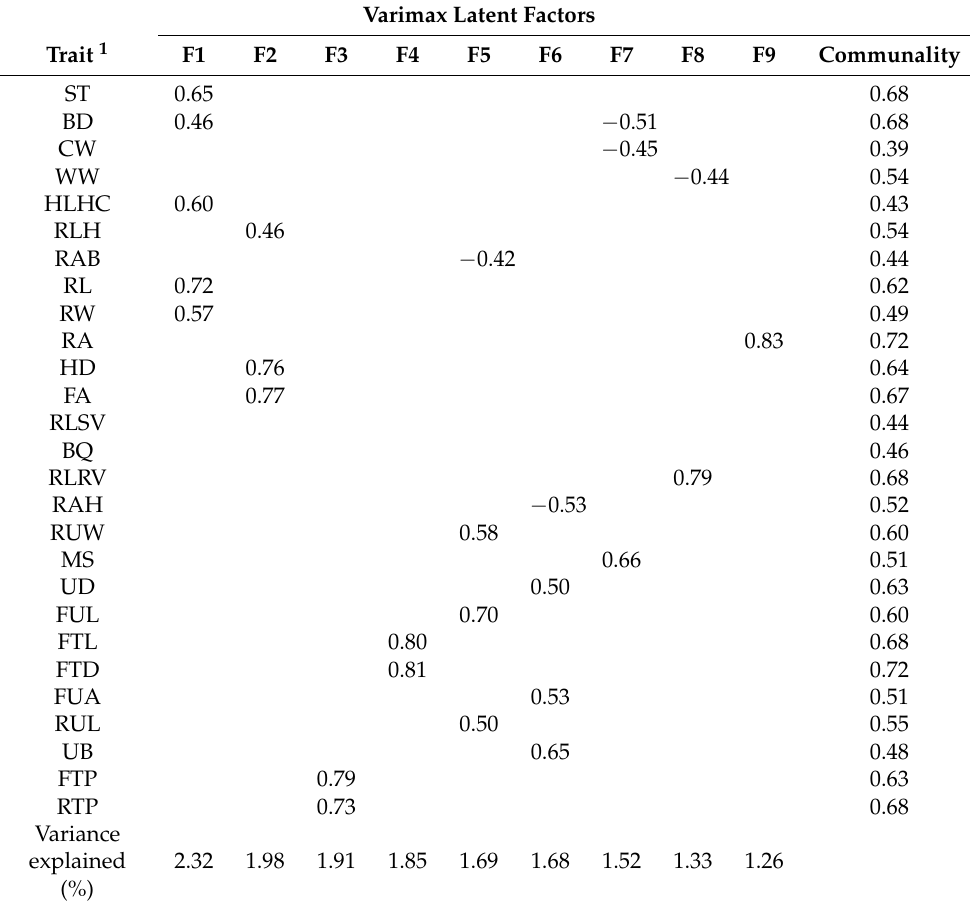
Table 4. Latent factors, loading of individual body conformation traits (loading coefficients ≥ | 0.40 | ), and communality after varimax rotation of the 27 body conformation traits in dual-purpose Simmental